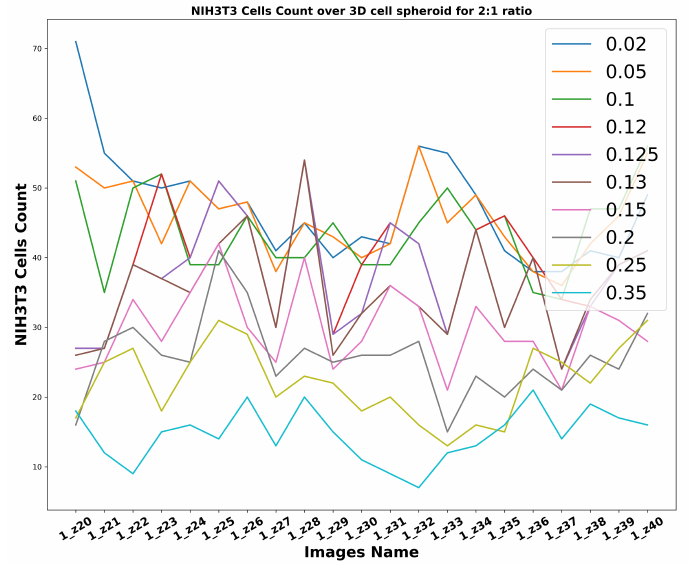
Figure 7. NIH3T3 cells count for 2:1 ratio of horizontal cross-sectional images for various threshold